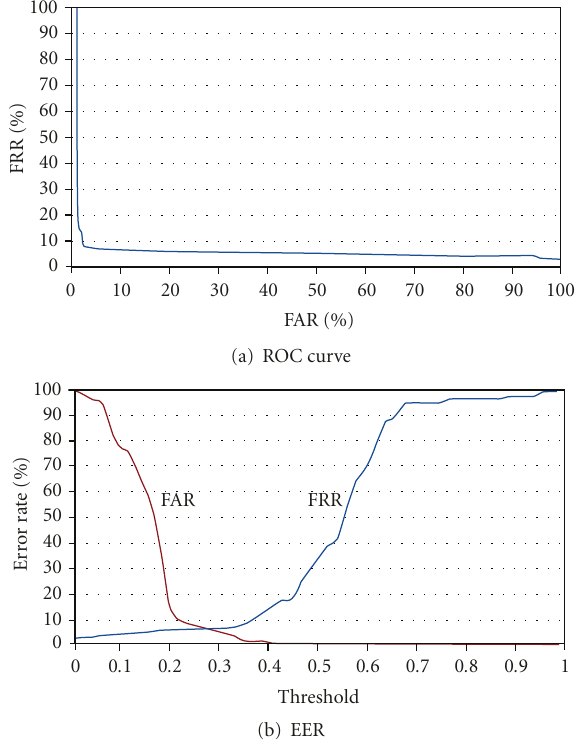
Figure 12: FERET database